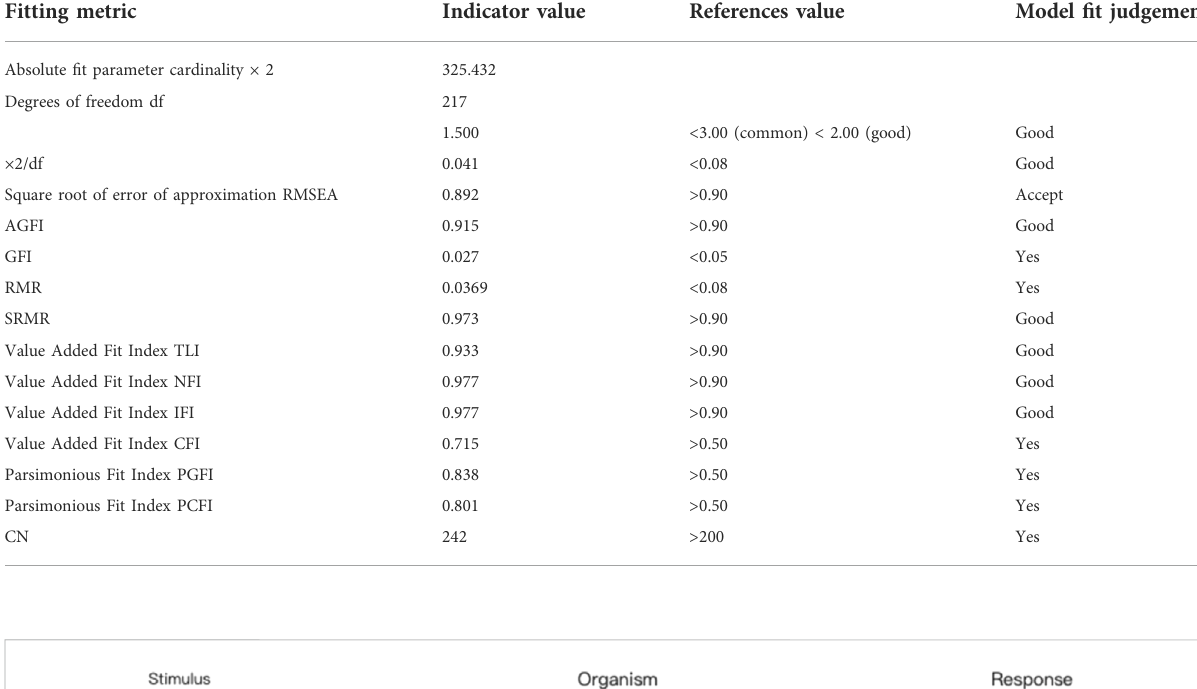
TABLE 2 Structural equation model fi t results.